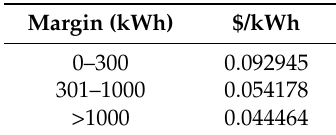
Table 4. The electricity usage cost